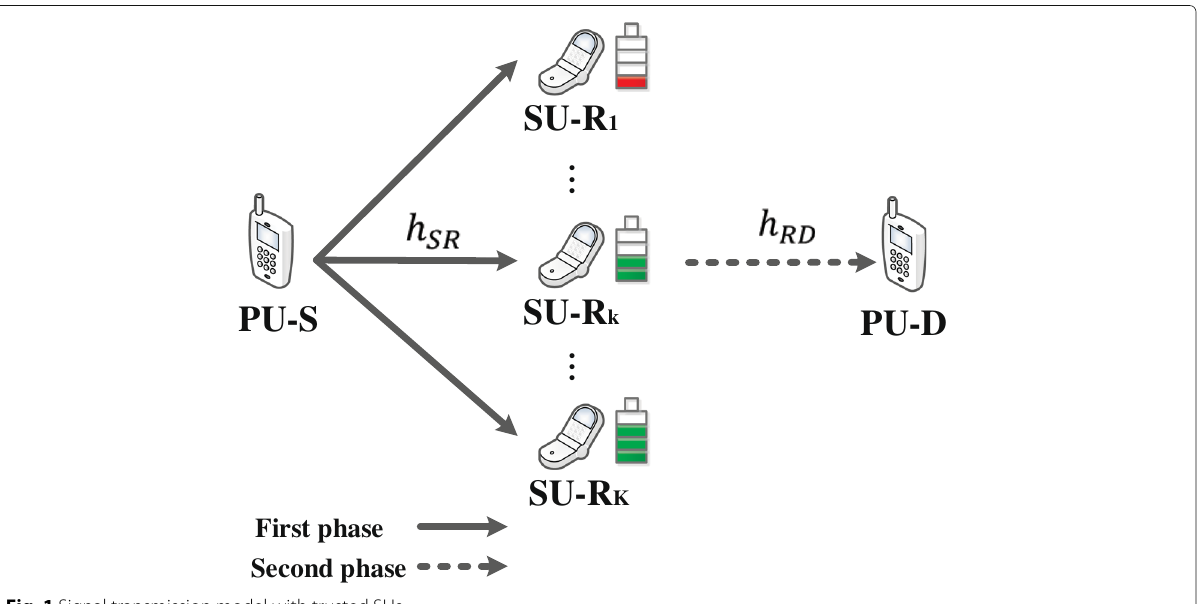
Fig. 1 Signal transmission model with trusted